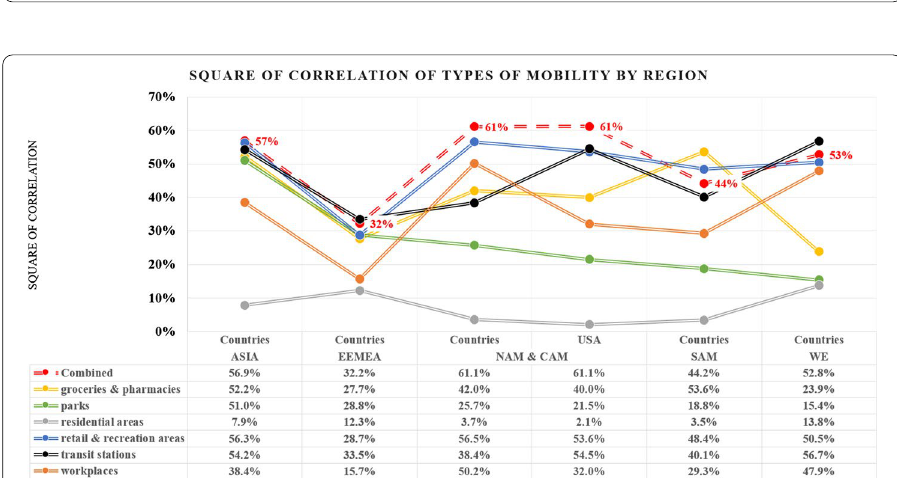
Fig. 8 Square of correlation by number of offset days—last 151 days of analysis